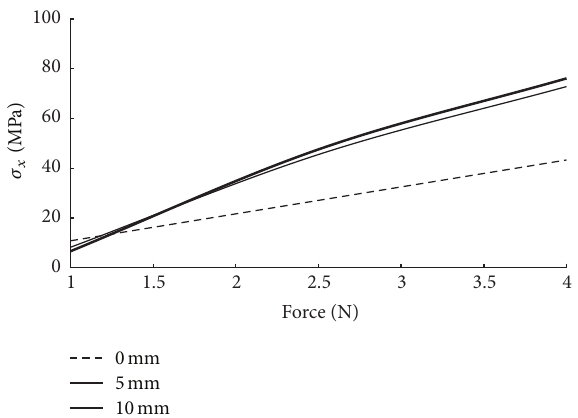
Figure 5: Variation of displacement at x -direction for FCR of Model I under the position angle of 34 ∘ .